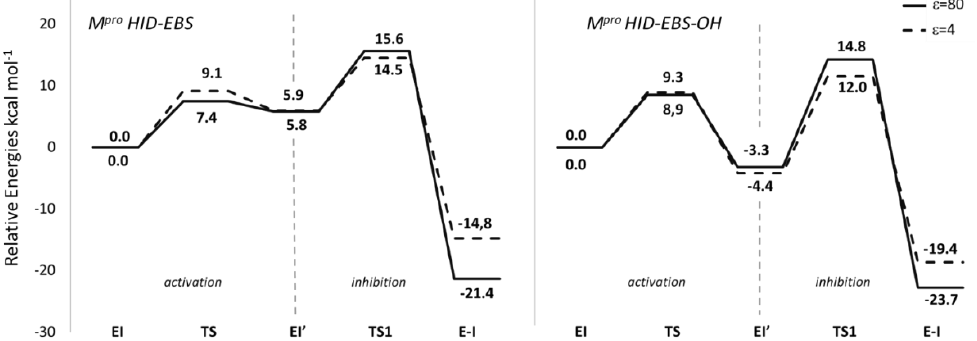
Figure 6. B3LYP-D3/6-31+G (2d,2p) free energy profiles of M pro SARS-CoV-2 covalent inhibition mechanism by EBS and EBS-OH in two phases: activation and inhibition through covalent bond formation, expressed in kcal mol −1 . Solid line indicates calculations in water ( ε = 80) and dotted line in the protein environment ( ε = 4).